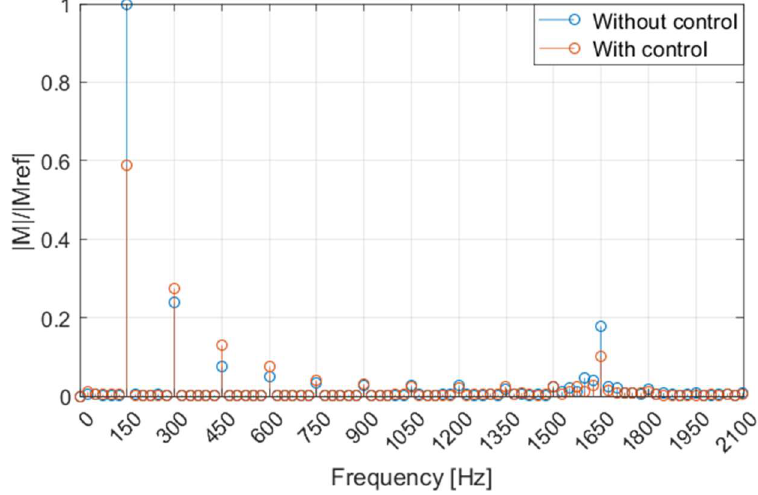
Figure 15. ( a ) Delivery mass flow rate. Shaft speed 1000 r/min; ( b ) Delivery pressure. Shaft speed 1000 r/min.